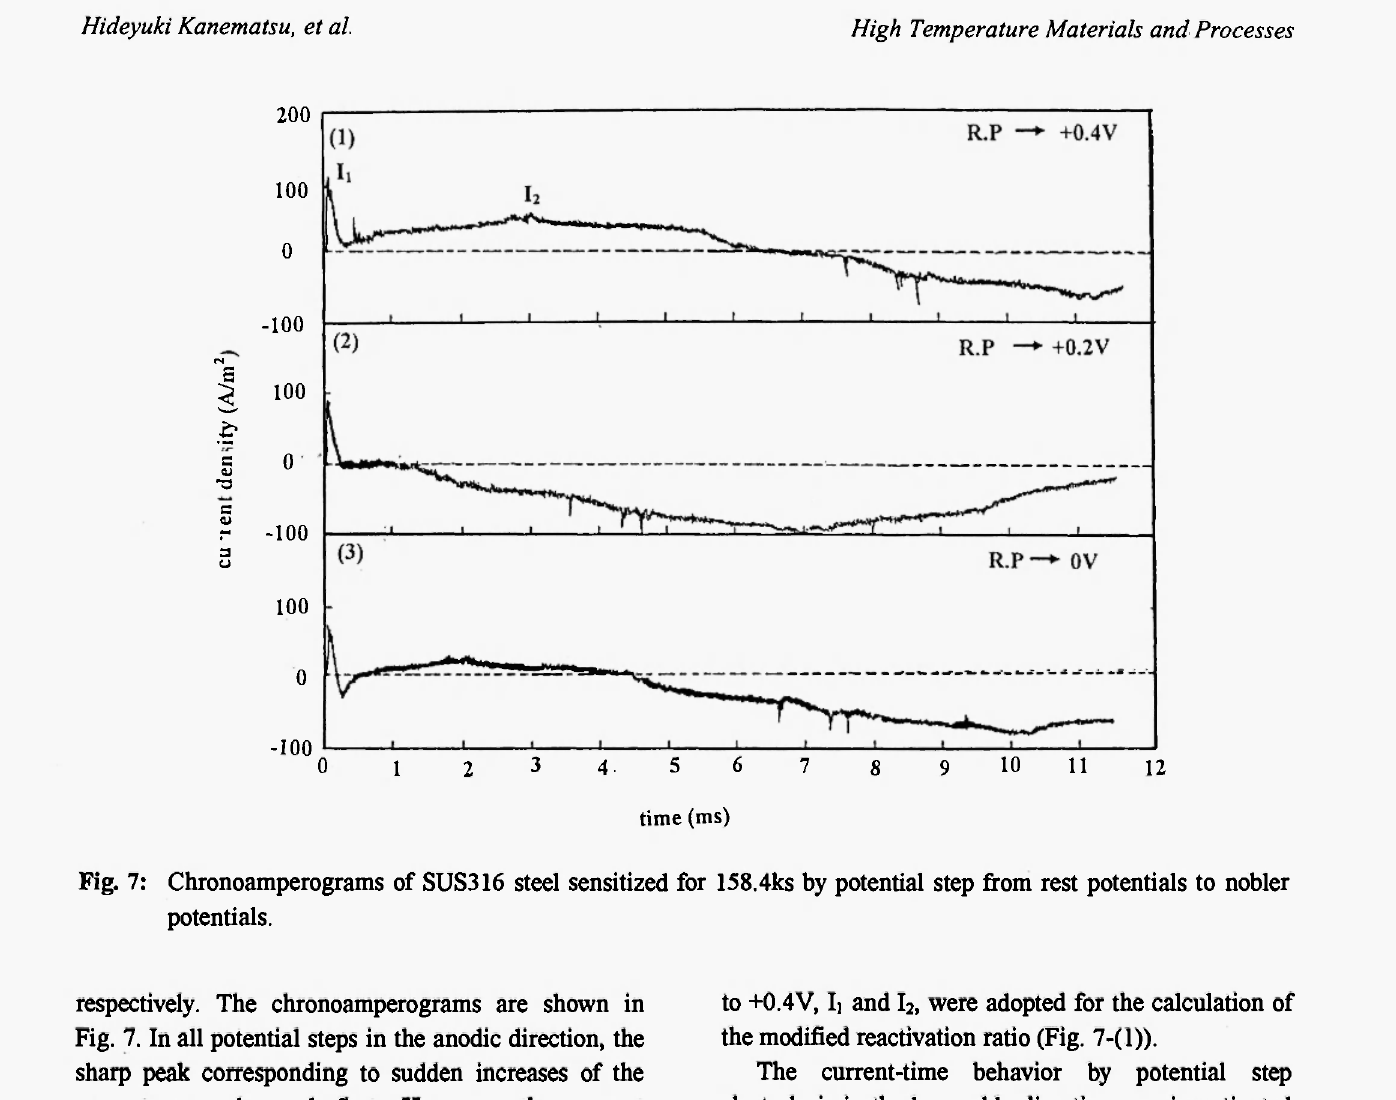
Fig. 7: Chronoamperograms of SUS316 steel sensitized for 158.4ks by potential step from rest potentials to nobler